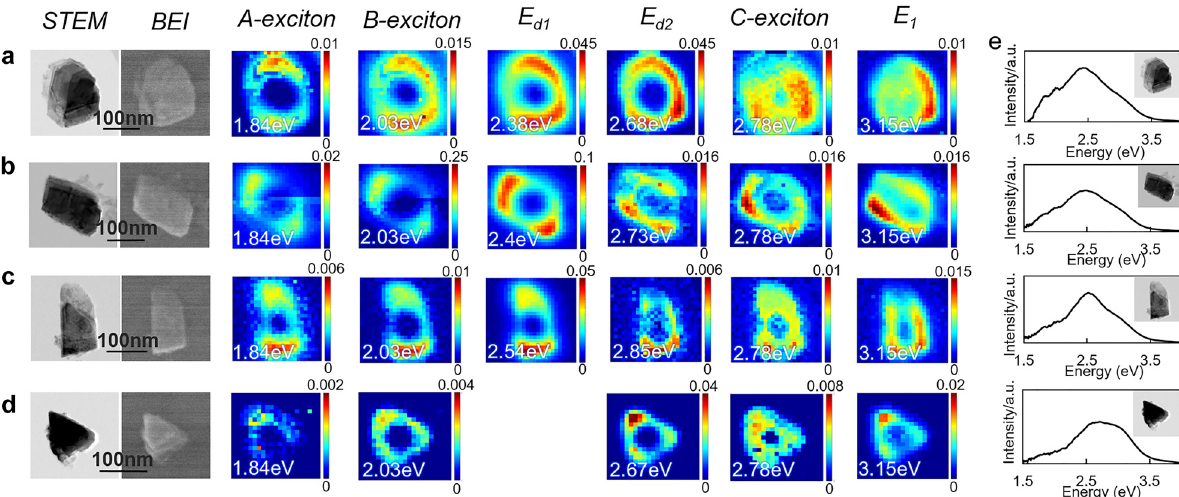
Figure 3: Non-polarized CL maps of individual MoS 2 nano fl akes with different shapes and sizes. STEM bright fi eld and BEI images, and deconvoluted CL maps experimentally observed for different shapes: (a) oval, (b), (c) rectangular, and (d) triangular nano fl akes, respectively. (e) The experimental CL spectra for the corresponding fl akes indicated on the left side. CL signals are collected in all the emission angles without